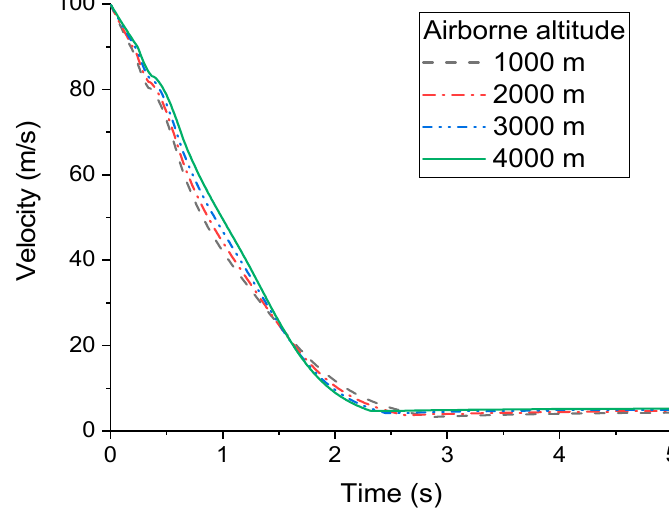
Figure 5. Velocity changes of parachute systems at different altitudes.